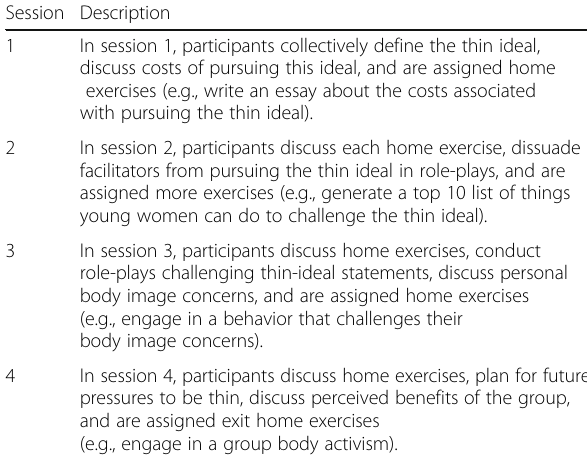
Table 1 Description of the Body Project intervention Session